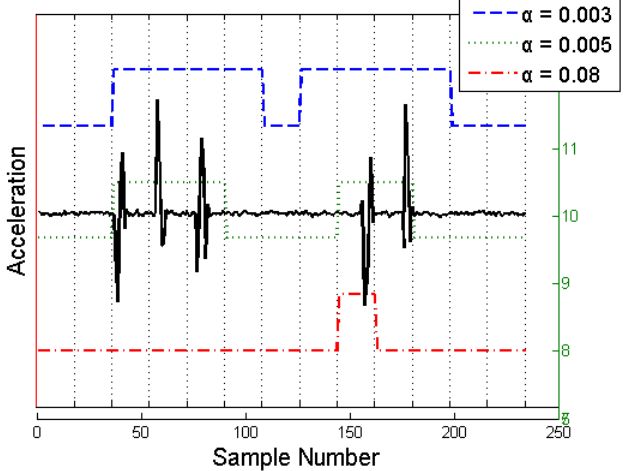
Figure 3. An effect of the threshold α from Equation (3) on